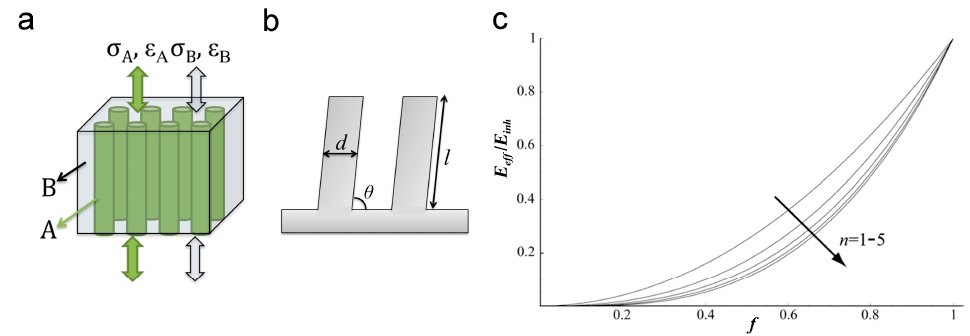
Figure 1. Proposed models to describe a pillar array. ( a ) A composite model of aligned fibers/pillars (A, green) embedded within a matrix (B gray) shows the strain ( ε ) under the stress ( σ ) along the long axis of fibers/pillars; ( b ) Schematic of a pillar array with pillar diameter d , length l and tilting angle θ ; ( c ) Dependence of the effective elastic modulus ( E eff ) of the structured adhesive normalized to inherent elastic modulus ( E inh ) expressed as a function of the filling ratio ( f ) for hierarchical levels n = 1–5. Reproduced with permission from [22].